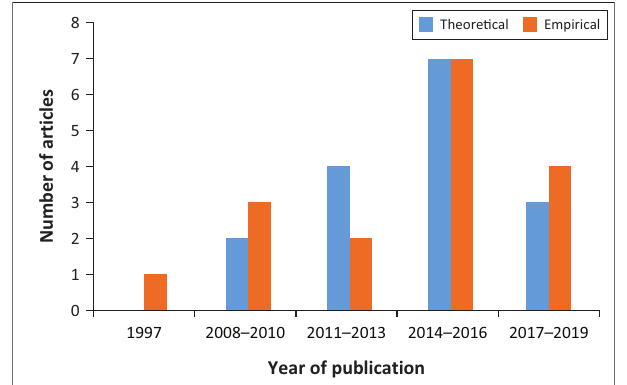
FIGURE 2: Chronological pattern of research type.